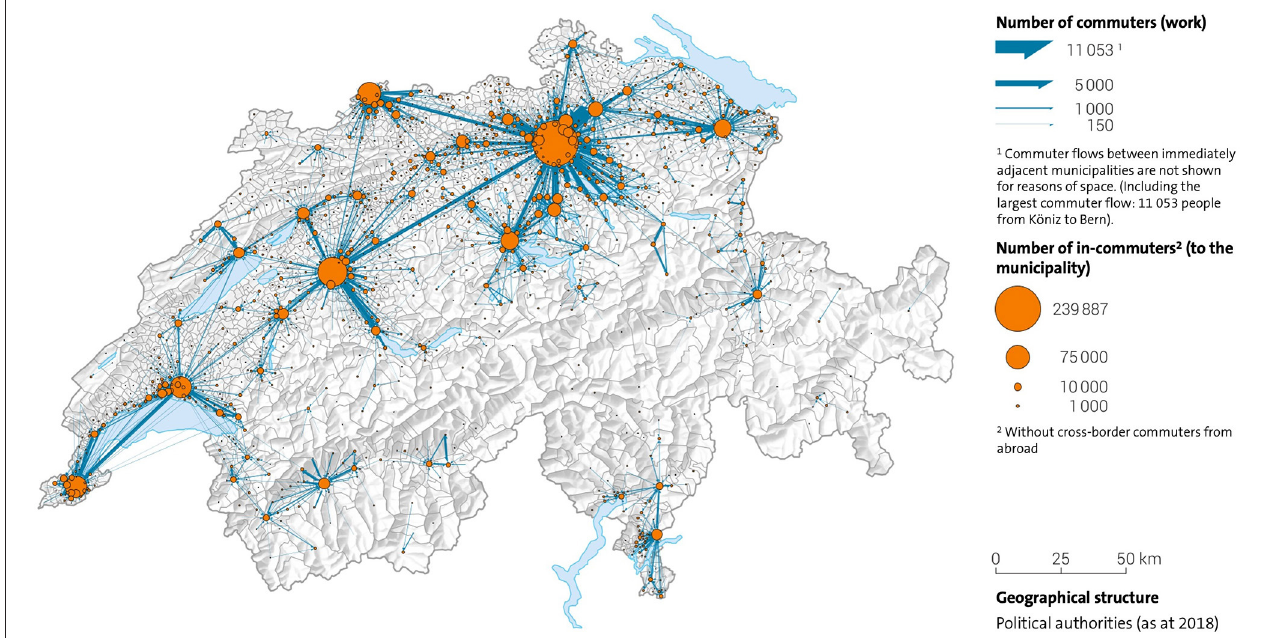
FIGURE 6 | The most important commuter flows in Switzerland 2018 in relation to major urban centers. Source: